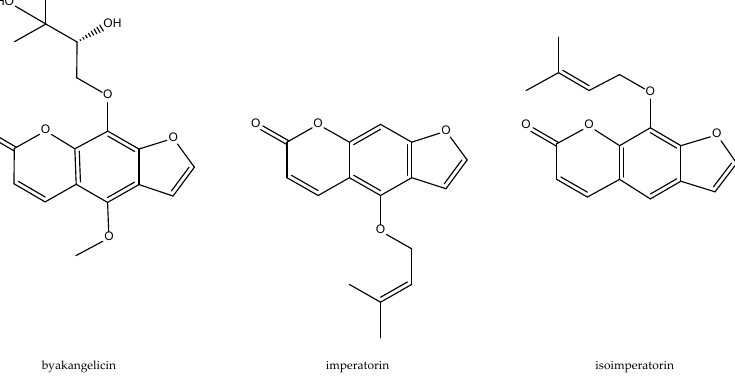
Figure 2. Bioactive anti-inflammatory (eicosanoid inhibition) and antioxidant principles from A. dahurica.